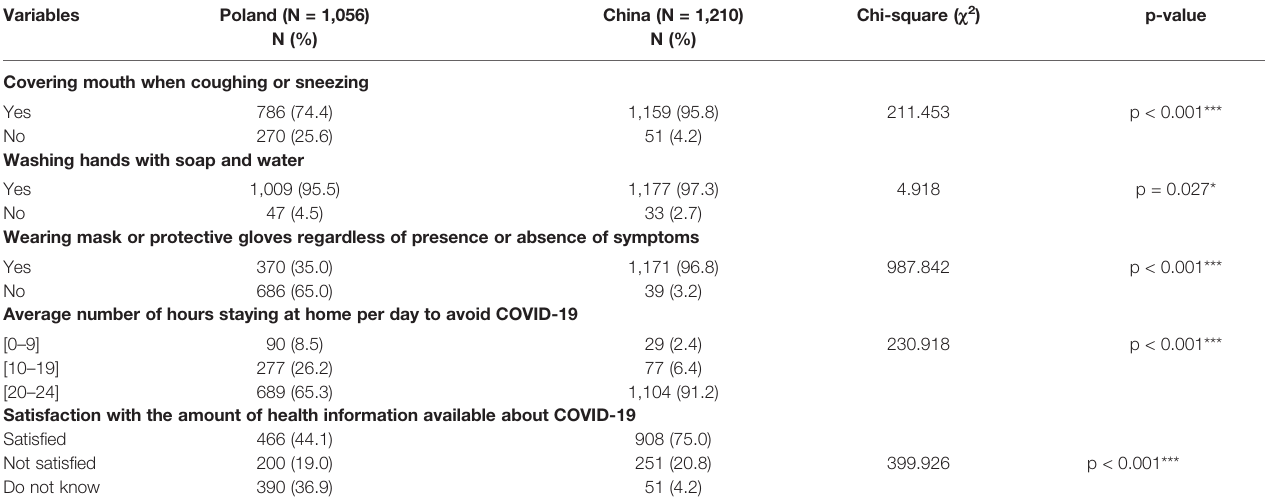
TABLE 5 | Comparison of precautionary measures in the past 14 days of the 2019 coronavirus disease (COVID-19) outbreak between Polish and Chinese respondents during the epidemic (N =